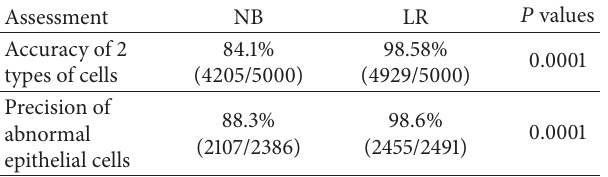
Table 3: The result of Step 2 classification. The accuracy and the precision as analyzed by NB and LR classifiers are shown.